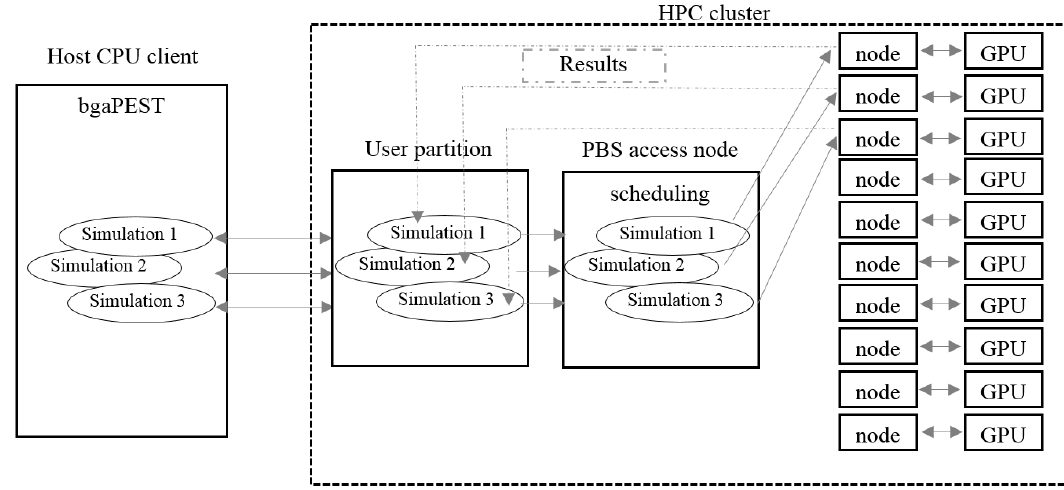
Figure 4. Schematization of the data transfer assuming three parameters and thus three parallel simulations.